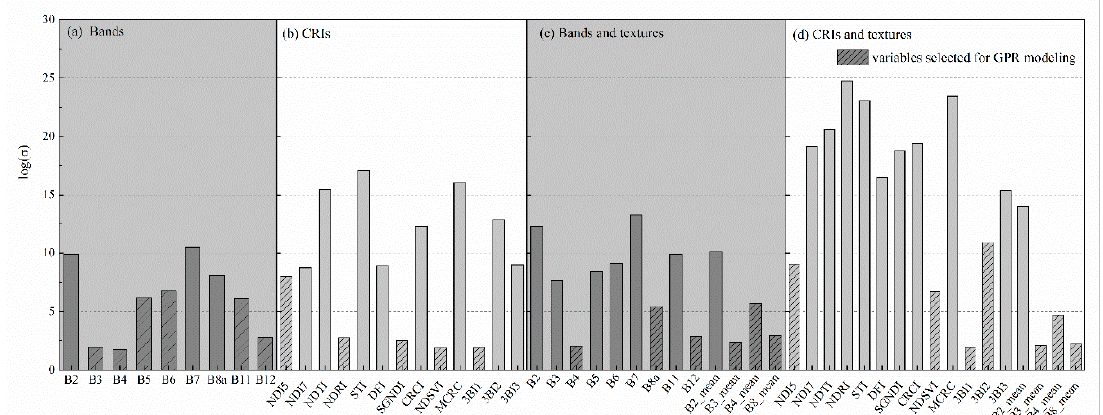
Figure 7. The logarithmic sigmas of GPR models with different groups of input predictors (( a ): MSI bands, ( b ): CRIs, ( c ): Bands and textures, ( d ): CRIs and textures).